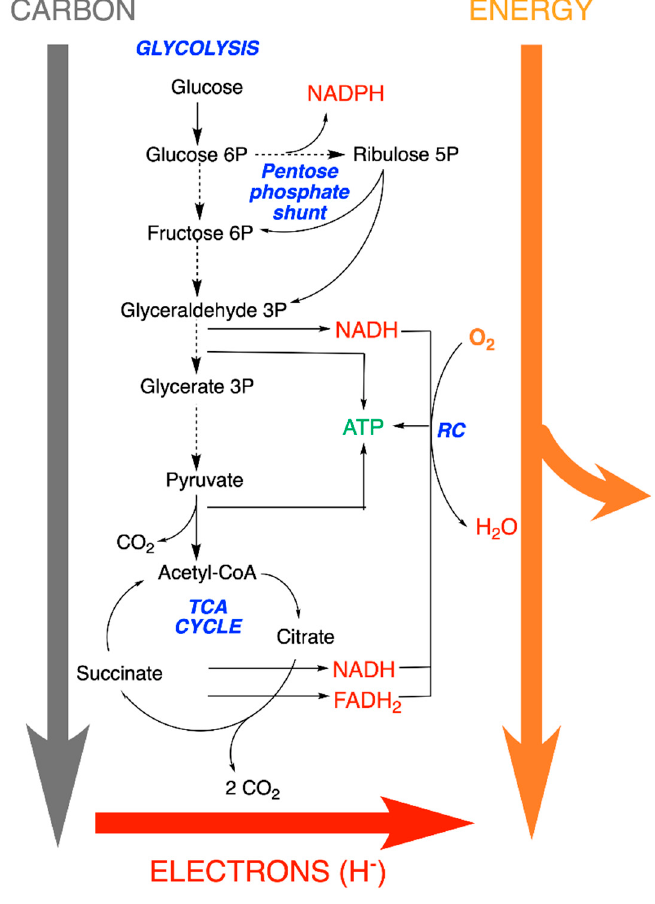
Figure 2. Catabolic flows of matter (carbon), energy and electrons through the central metabolic pathways (glycolysis, tricarboxylic acid (TCA) cycle and pentose phosphate shunt). For simplification, no subcellular compartmentation is indicated, and the scheme may concern any prokaryotic or eukaryotic organism. The driving forces depend on differences in concentrations and in the structural arrangement between products and reactants’ free energy ( ∆ G° ) and redox potential ( ∆ E ). (RC, respiratory chain).